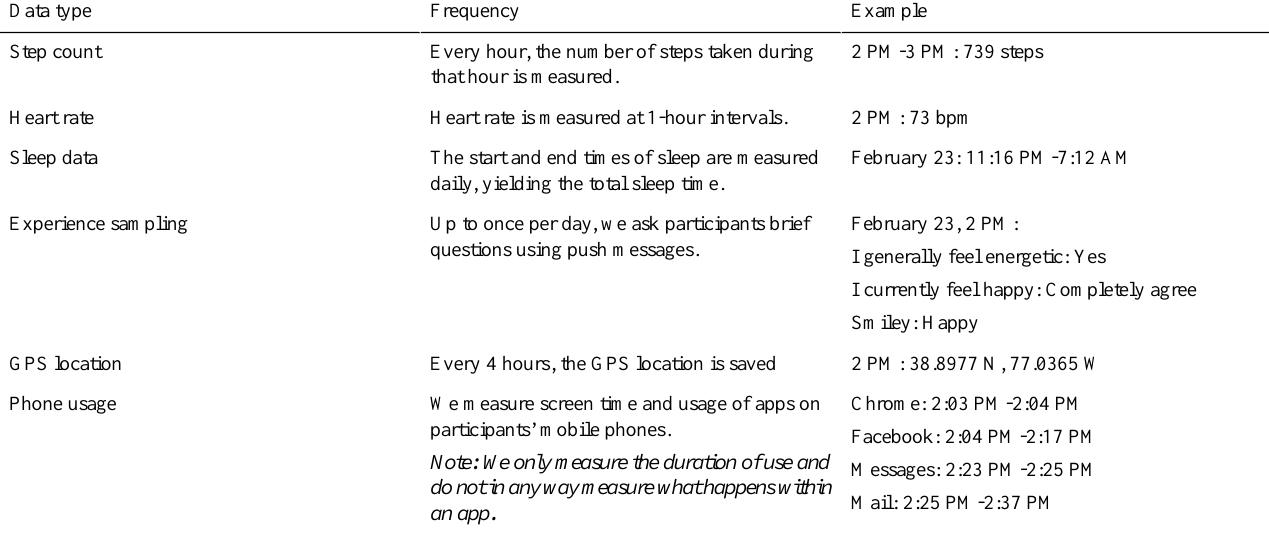
Table 1. Summary of data collected in Health Telescope. ExampleFrequencyData